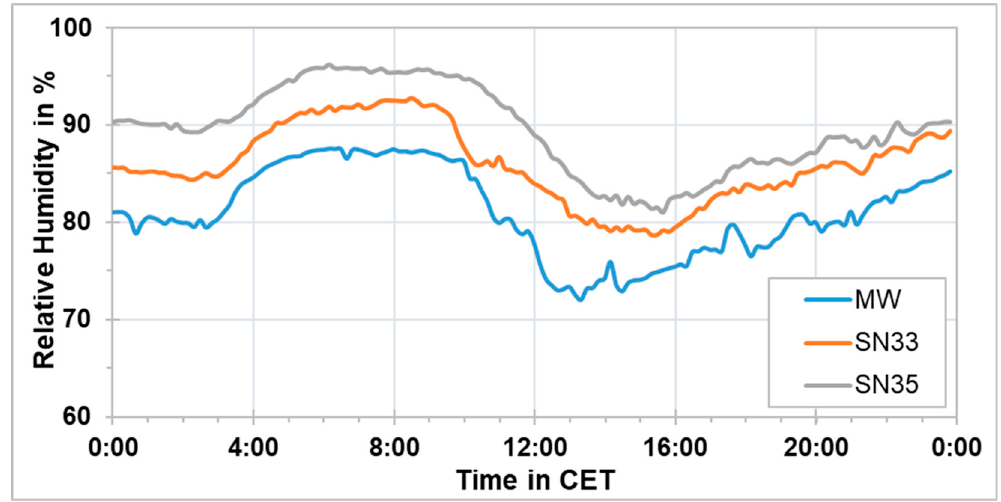
Figure 9. Relative humidity at three stationary locations along the route of the rack railway on 21 February 2019 for 24 h.